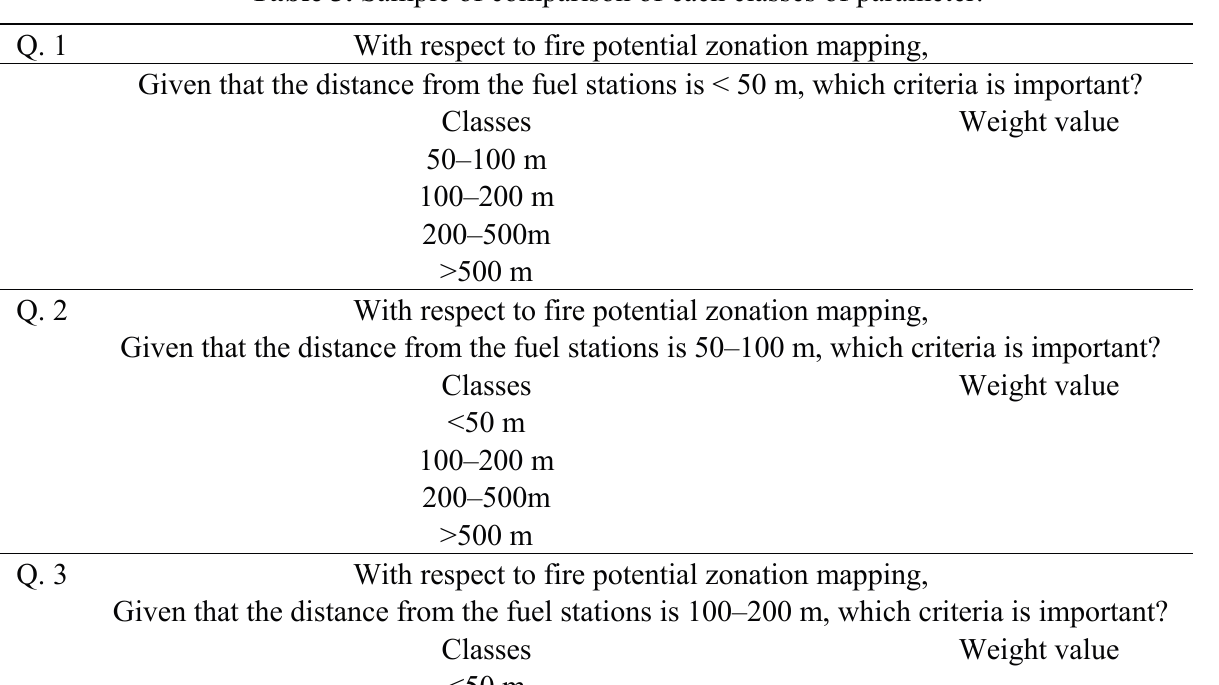
Table 3. Sample of comparison of each classes of